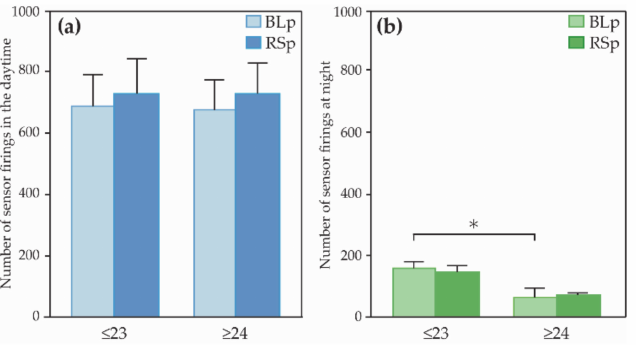
Figure 5. Comparison of ( a ) the number of sensor firings in the daytime and ( b ) the number of sensor firings at night. Error bars indicate standard error, and asterisk indicates that p -value was less than 5%; BLp: Baseline phase, RSp: Robot support